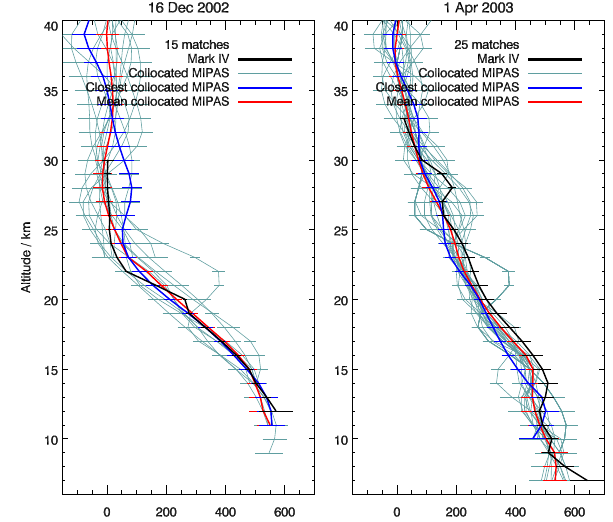
Figure 27. Two MkIV CFC-12 profiles are compared with collo- cated MIPAS of the FR period. For the measurement on 16 Decem- ber 2002, 16 collocated MIPAS measurements were found, while 25 MIPAS profiles coincided with the 1 April 2003 MkIV measure- ment. The setup is similar to Fig.